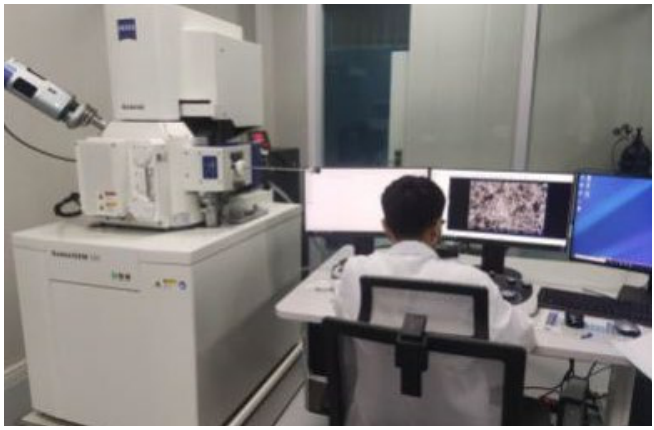
Figure 4. JSM-5600LV electron microscope.